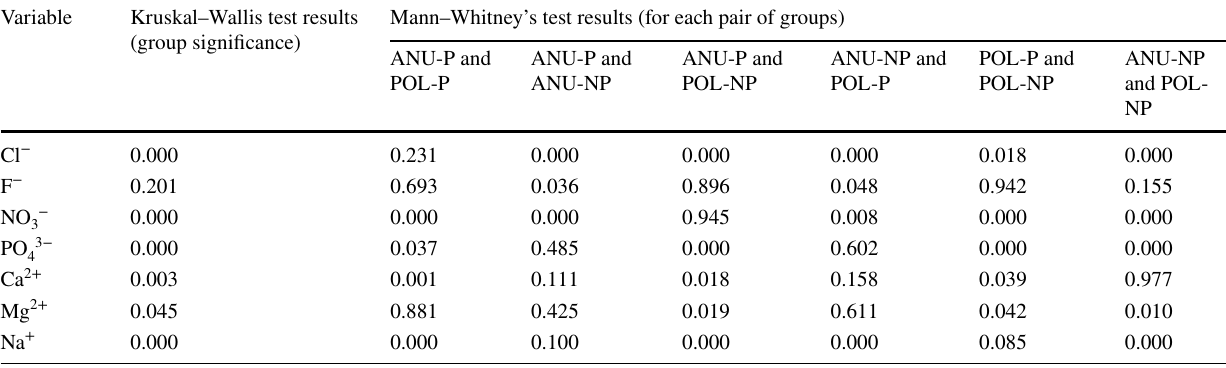
Table 5 Kruskal–Wallis (KW) test with Mann–Whitney’s post hoc test results ( p values) for primary data